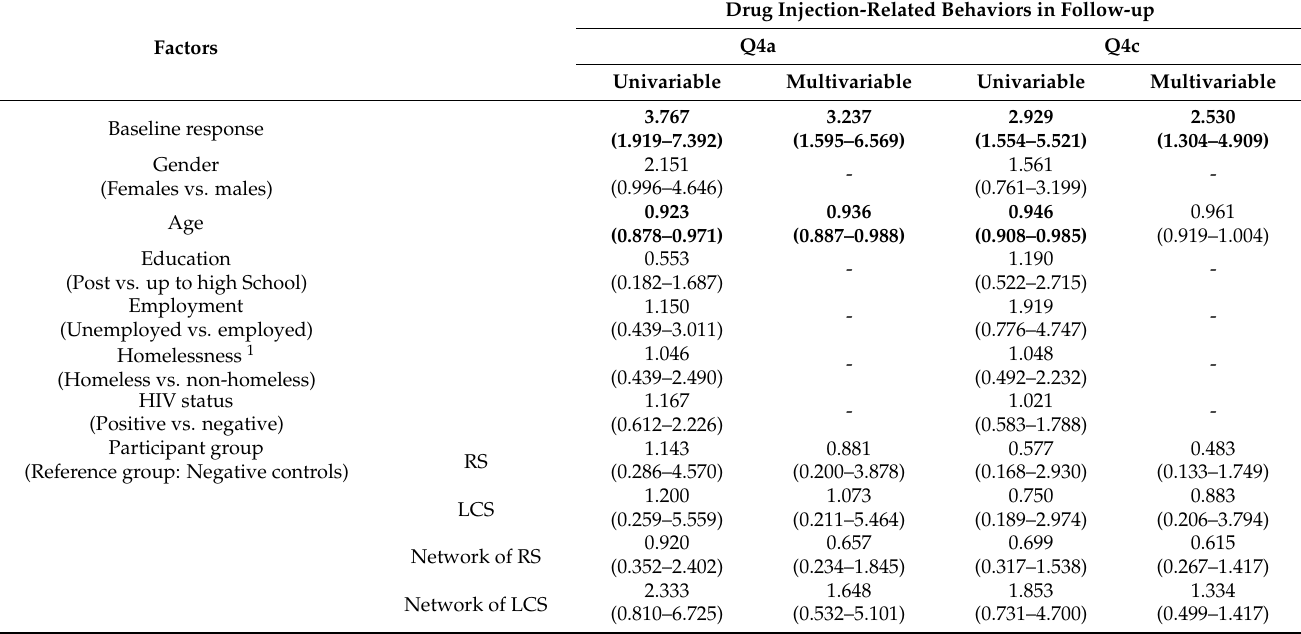
Odds ratios of variables whose confidence intervals do not include 1 are shown in bold. Abbreviations: HIV, human immunodeficiency virus; RS, recent seeds; LCS, control seeds with long-term HIV